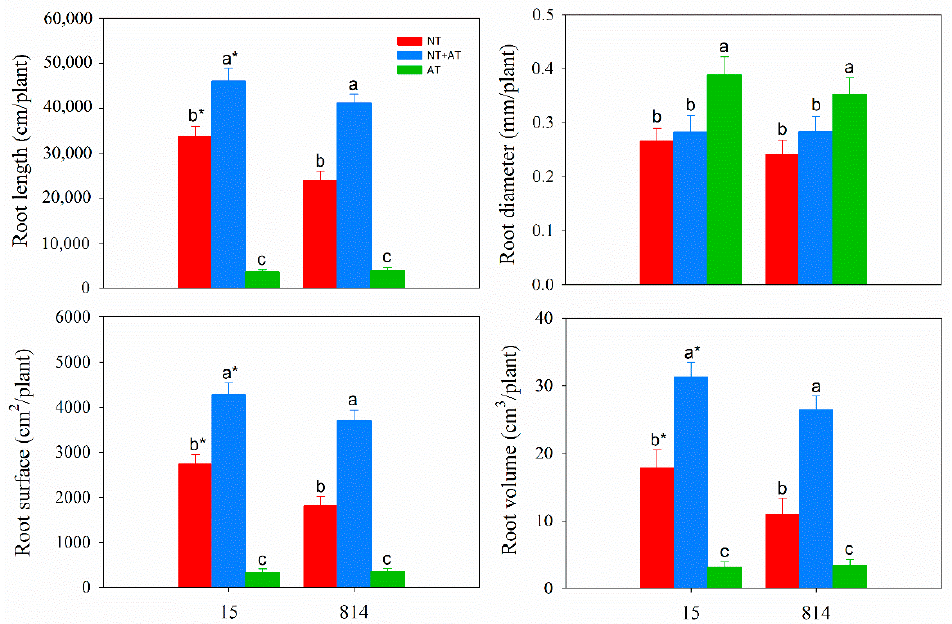
Figure 2. Root architecture of the two cultivars under different N treatments. The three treatments contained the same amount of N (15 mmol/L). Different letters at the top of the histogram bars denote significant differences among treatments for the same cultivar ( p < 0.05); asterisks (*) at the top of the histogram bars denote significant differences between cultivars in the same treatment ( p < 0.05); vertical bars indicate the SD (n = 5).